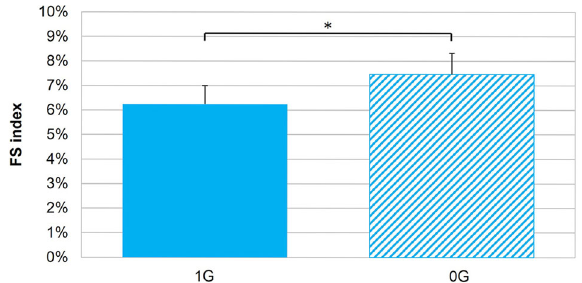
Fig. 2 Comparison of the fl ow stasis (FS) index predicted under 1G and 0G (error bar: standard error; n = 16; * p < 0.05; paired Student t